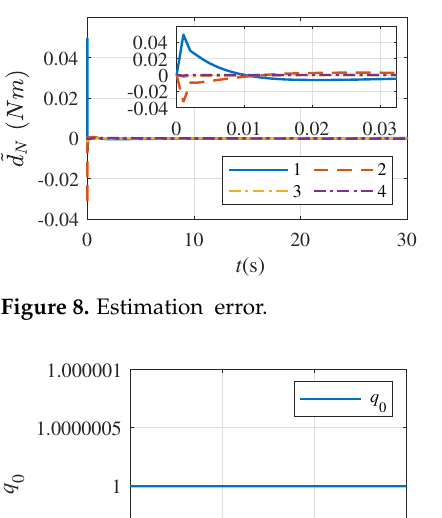
Figure 7. Control torque without disturbance.